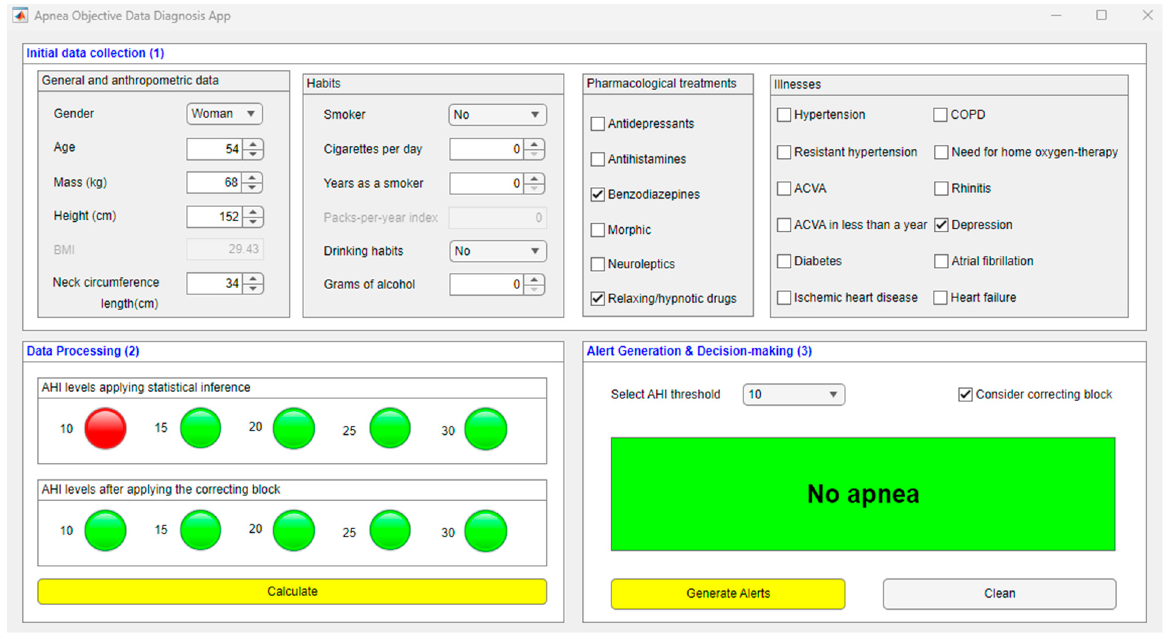
Figure 6. Application screenshot. Determination of the risk of suffering from OSA associated to the different threshold levels.